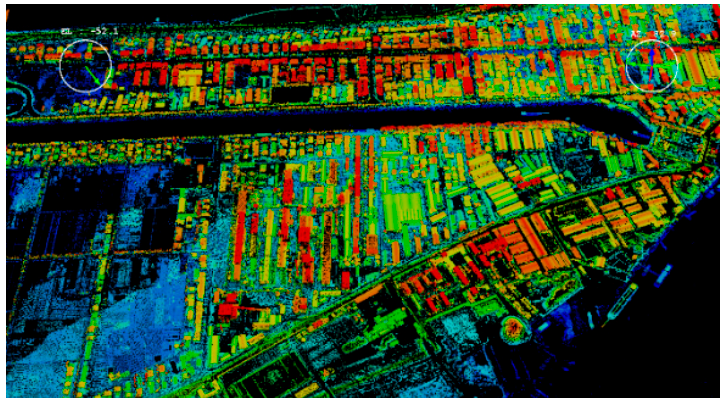
Figure 1. Location of the Gongshuangcha detention basin in the Dongting Lake area. Figure 2. Example of airborne light detection and ranging (LiDAR) point cloud data.